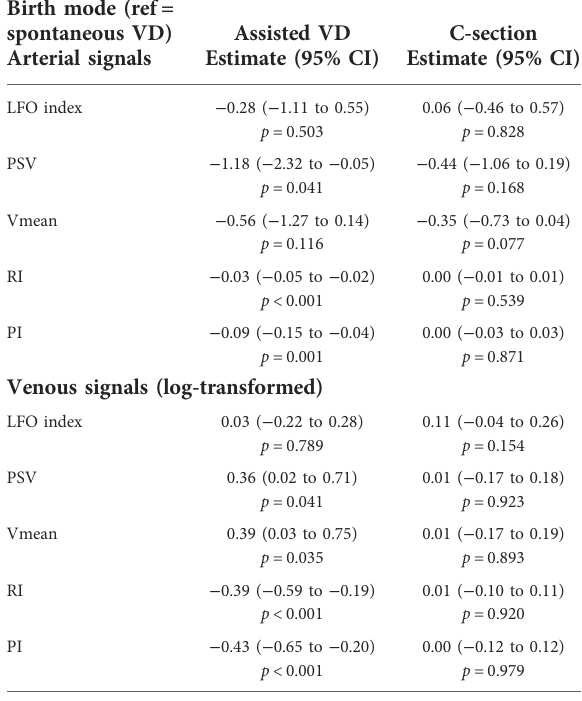
TABLE 5 Results from a linear mixed model to evaluate the association between cerebral hemodynamics and birth mode. Birth mode (ref = spontaneous VD)